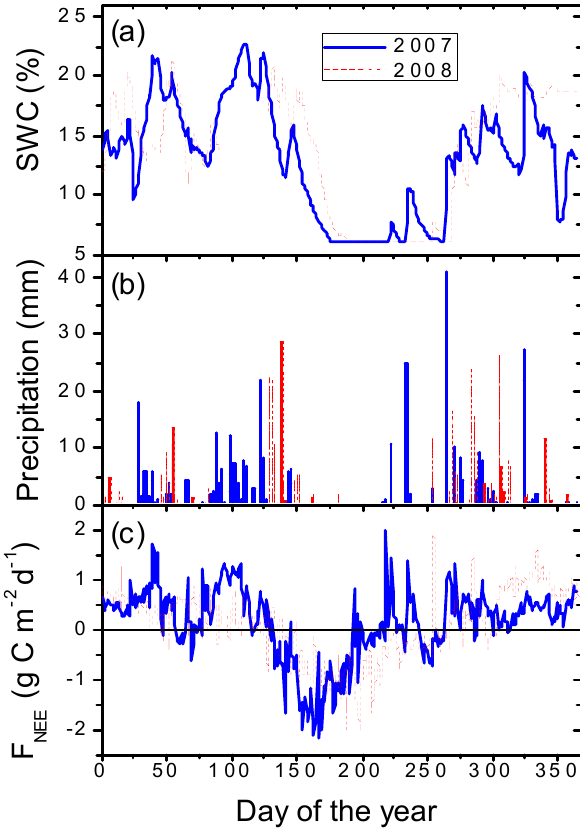
Fig. 2. Average daily environmental conditions in the Mediter-